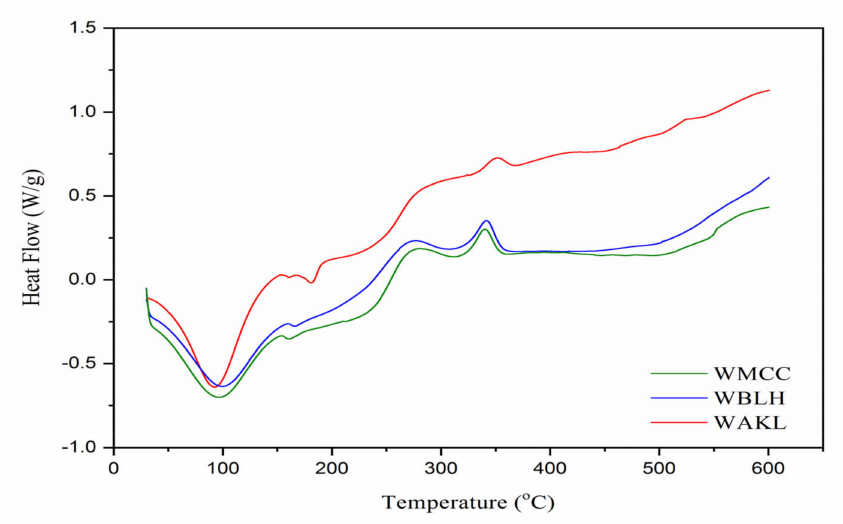
Figure 6. DSC spectra of WAKL, WBLH, and WMCC